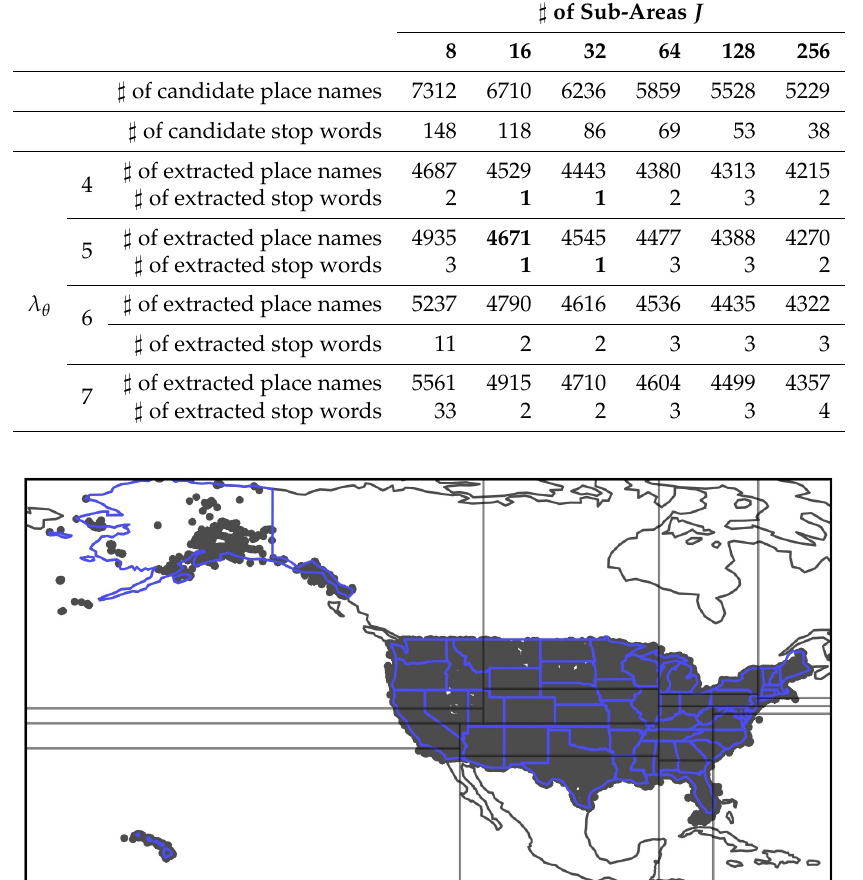
Figure 6. How the United States was divided into J = 16 sub-areas. The dark circles represent the geographical coordinates of the 2,206,873 images. The whole area, which is the minimum bounding box containing all coordinates, is divided so that each sub-area has the same number of